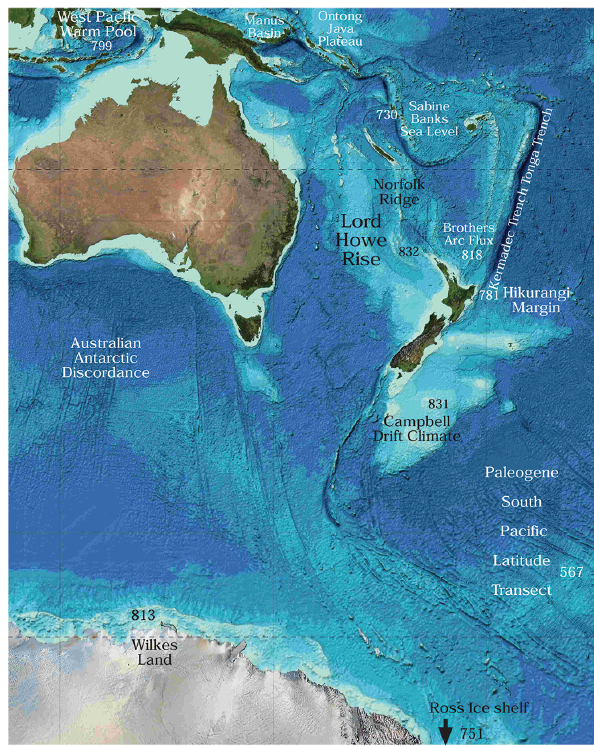
Figure 1. Location of existing drilling proposals in the southwest Pacific region. Base map adapted from General Bathymetric Chart of the Oceans (GEBCO) www.gebco.net. Proposals 730 and 799 are not discussed in this